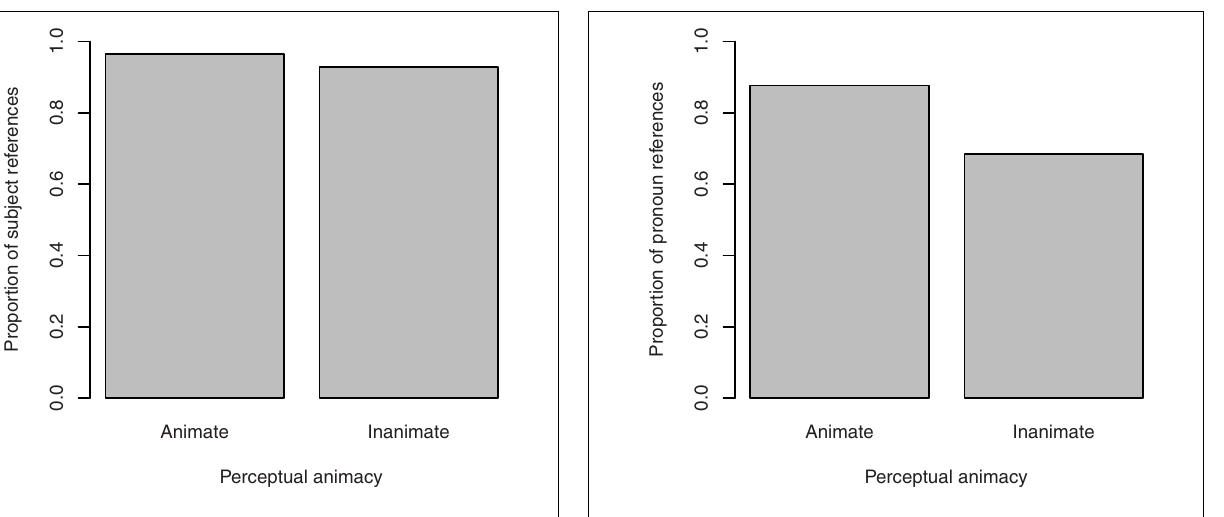
FIGURE 7 | Proportion of subject references to the target figure in the description of the transitive action in Experiment 2, by its perceptual animacy.